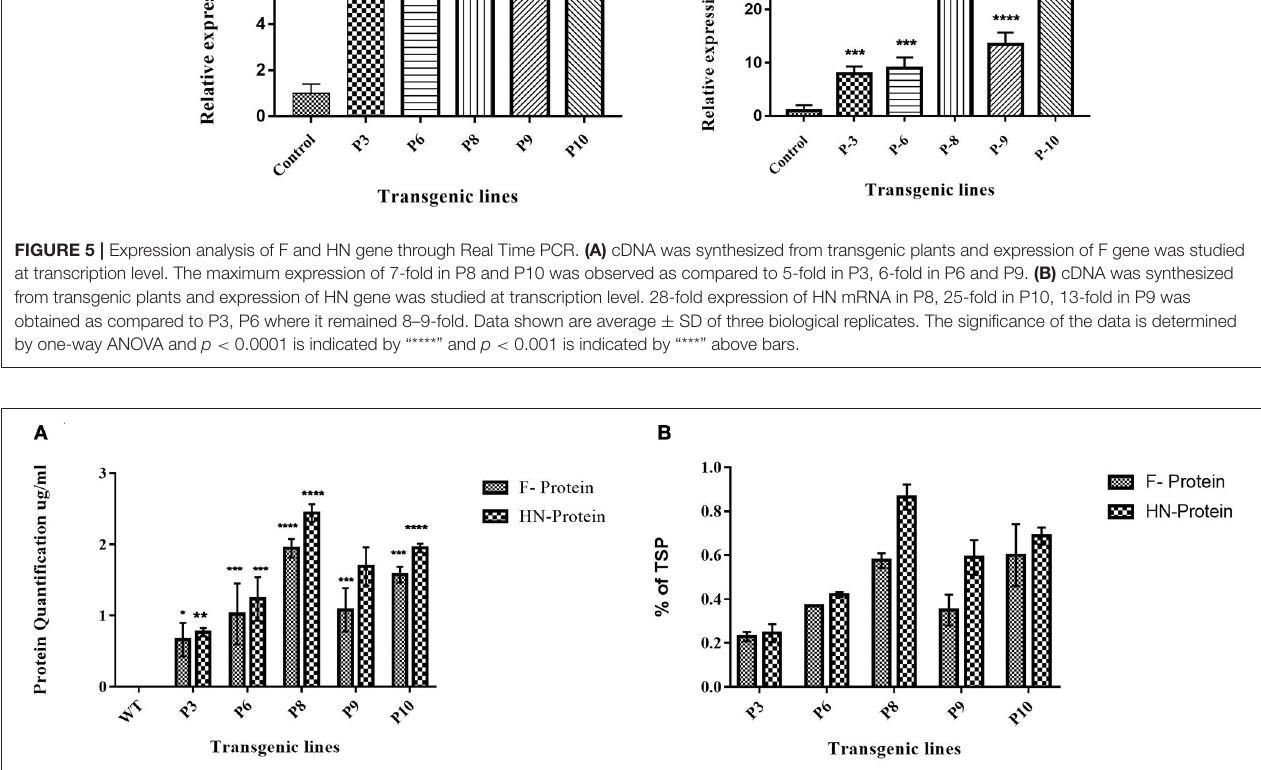
FIGURE 6 | Quantification of F and HN protein in transgenic maize leaves and seeds. Quantification of F and HN protein was done through ELISA. Percent of TSP was calculated by comparing the absorbance to the Standard plot of purified F and HN through ELISA. (A) The concentration of F protein in P6 and P8 showed highest protein concentration of 1.5 and 1.66 µ g/ml in leaf, respectively. While the highest concentration of HN protein 2.4 and 1.95 µ g/ml of total seeds protein was calculated in P8 and P9, respectively. Data shown are average ± SD of three biological replicates. The significance of the data is determined by one-way ANOVA and p < 0.0001 is indicated by “****,” p < 0.001 is indicated by “***,” p < 0.01 is indicated by “**” and p = 0.01 is indicated by “*” above bars (B) Similarly, the highest TSP was observed in P8 for both F and HN which was 0.7% and % of 0.8%, respectively. Data shown are average ± SD of three biological